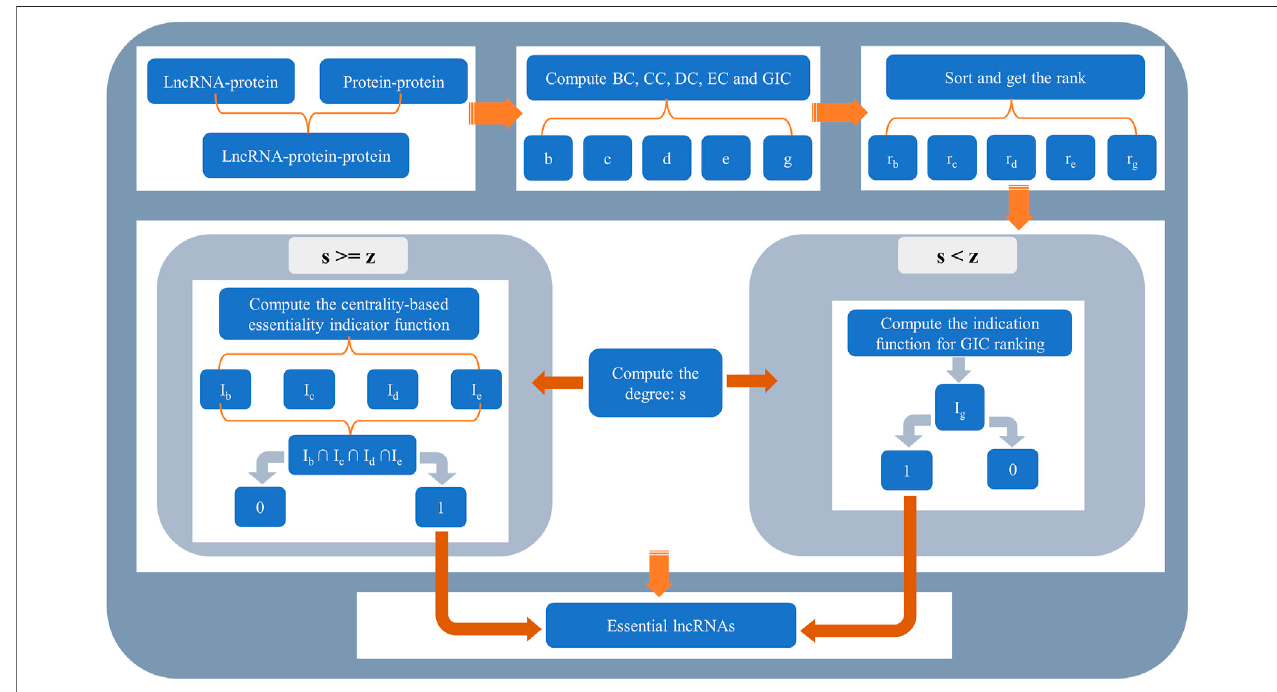
FIGURE 2 | The fl owchart of SGII. The method SGII consists of two parts. For lncRNAs whose degree is greater than or equal to z , four types of centralities were used to determine whether they were essential lncRNAs. For lncRNAs whose degree is less than z , GIC was